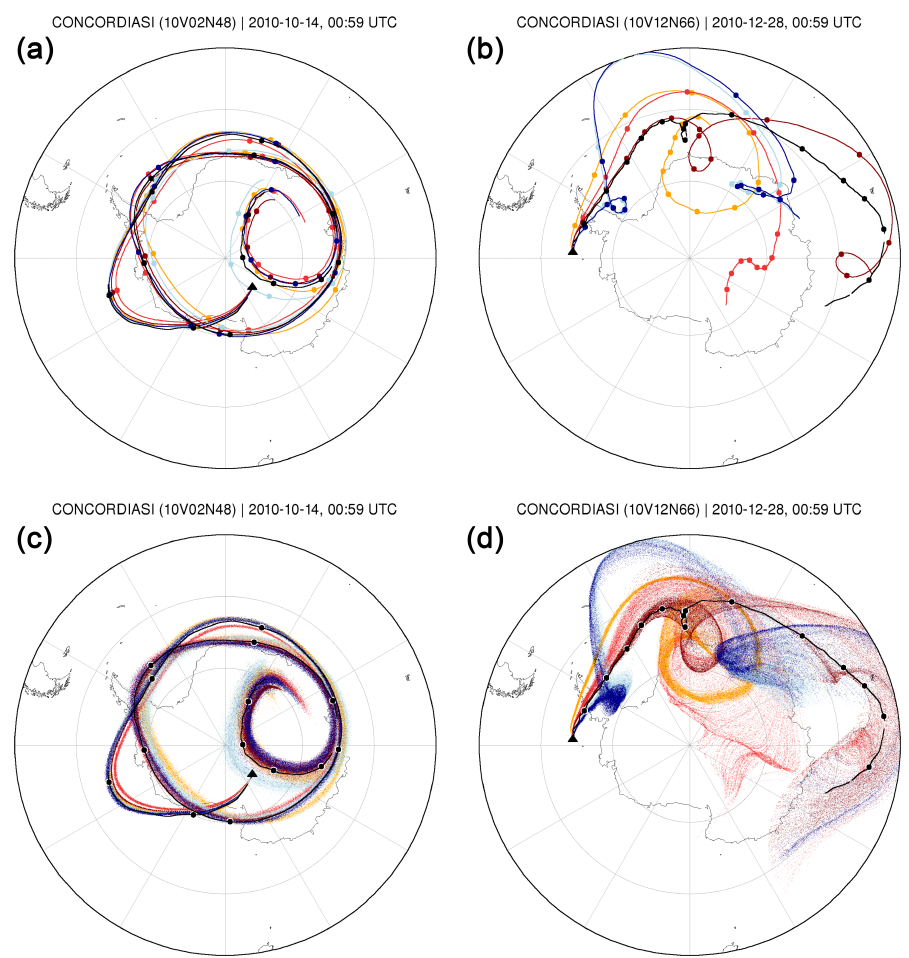
Figure 8. Examples of trajectories calculated with different meteorological analyses (dark blue: ECMWF OA; light blue: ERA-Interim; dark red: MERRA-2; light red: MERRA; orange: NCEP/NCAR) and corresponding Concordiasi balloon trajectory (black). Plot titles provide the starting times and triangles indicate the starting positions of the trajectories. Circles indicate trajectory positions at 00:00UTC each day. Plots at the top show individual trajectories calculated without diffusion. Plots at the bottom illustrate dispersion simulations with diffusion being